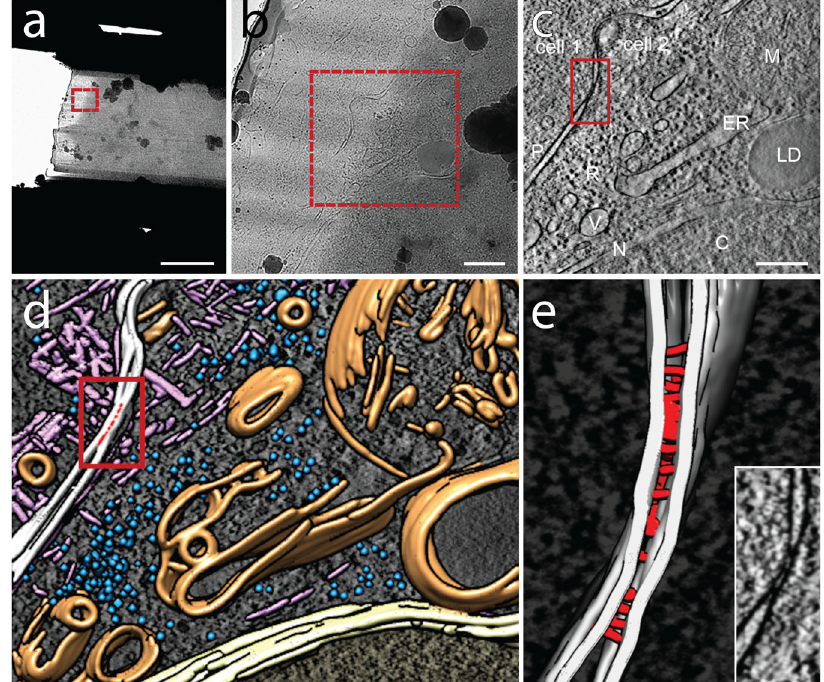
Fig. 6 | In situ cellular tomography of shape-guided thinned region of micro- patterned adhering PTK-1 cell – cell contacts. a Top view of a cryo-FIB-milled lamella across a vitri fi ed PTK-1 cell – cell contact site imaged using a cryo- transmission electron microscope. The milling patterns above and below the sample were adjusted to leave a central ~200nm thin slice (lamella) supported by the surrounding unmilled, vitri fi ed material. The cuts below and above the lamella are for releasing stress introduced by the milling. Cell – cell contact regions are identi fi ed visually using the shape of the two interacting cells in cryo-SEM images (Fig. S12a, b illustrate shape-guided targeting of a region of interest). b Higher magni fi cationoftargetedregionmarkedbytheredboxin( a )representingthearea of tomogram acquisition. c 2-nm thick virtual slice through a tomogram of the lamella region marked by the red box in b , showing a clearly discernible cell – cell